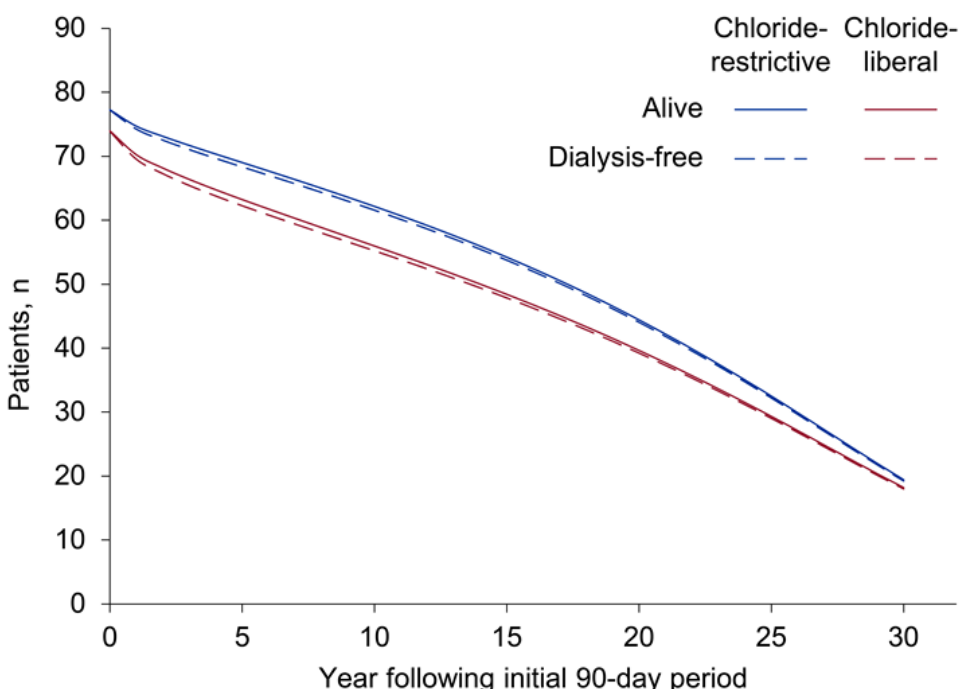
Figure 3. Health-state Outcomes in the Model Cohort